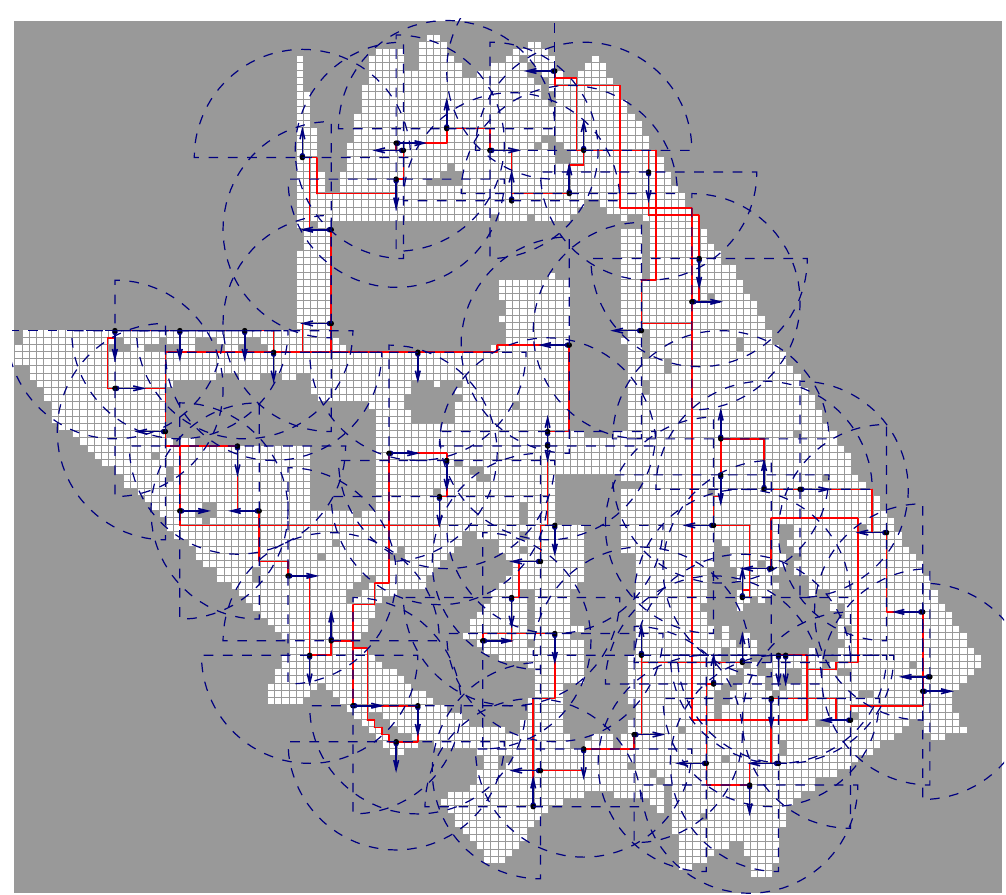
Figure 14. The exploration plan generated for the map of the Freiburg University campus (obstacles are represented in gray). The positions of the sensing configurations are represented with blue dots, blue arrows indicate their orientation and dashed-lines their field of view. A closed path through the configurations is shown in red.